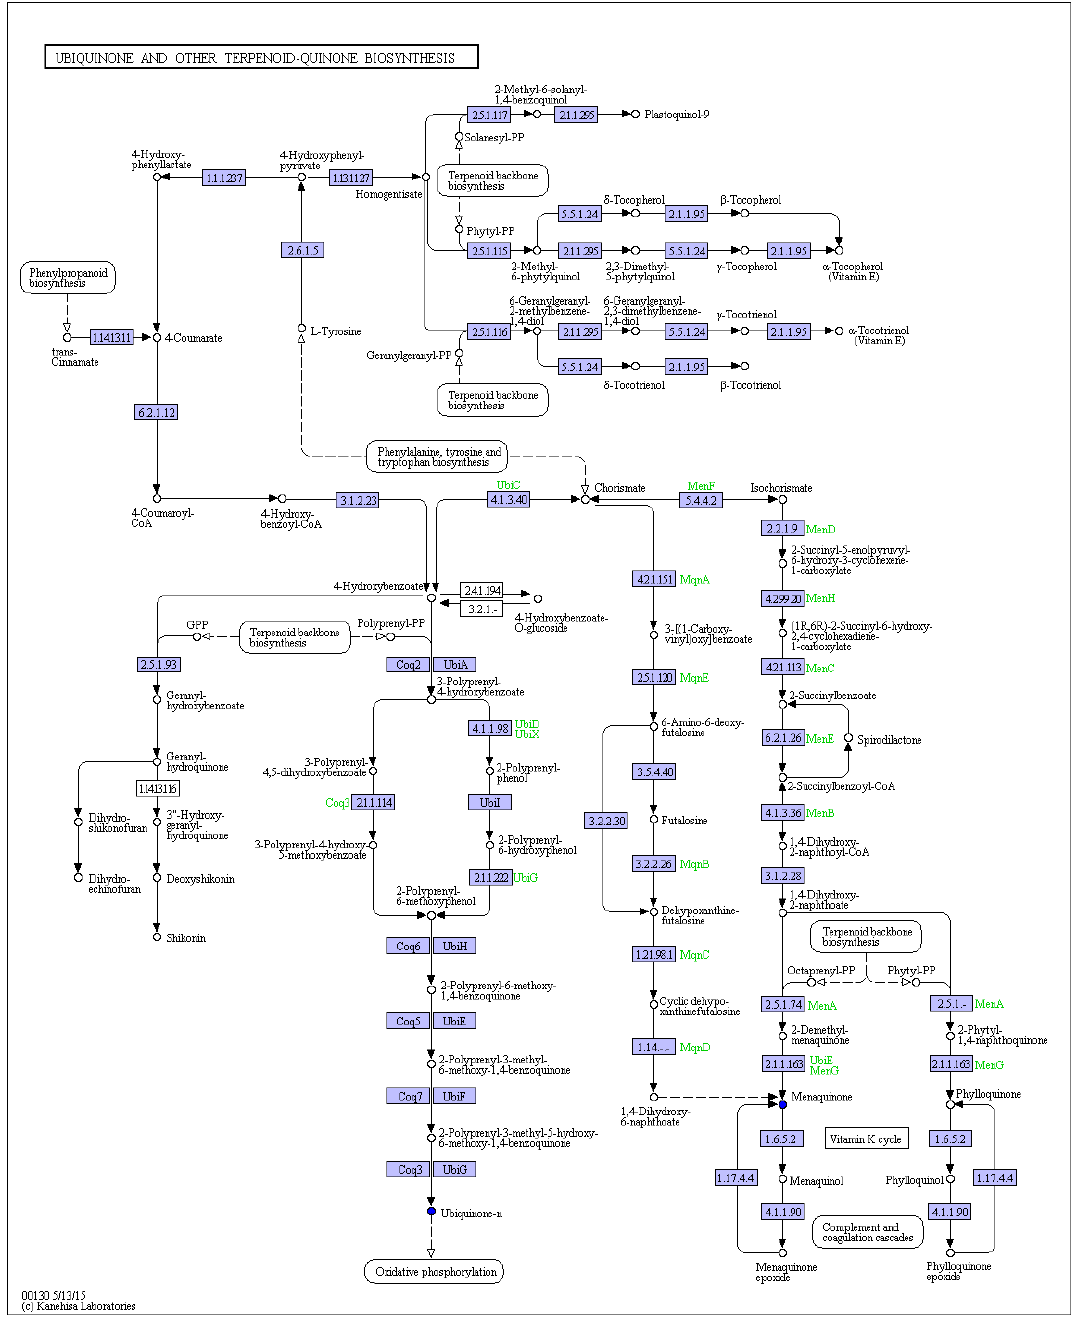
Figure A4. Isoprenoid quinones (ubiquinone-10 and menaquinones) produced by Asaia lannensis and Asaia bogorensis . Isoprenoid quinones are marked in blue.